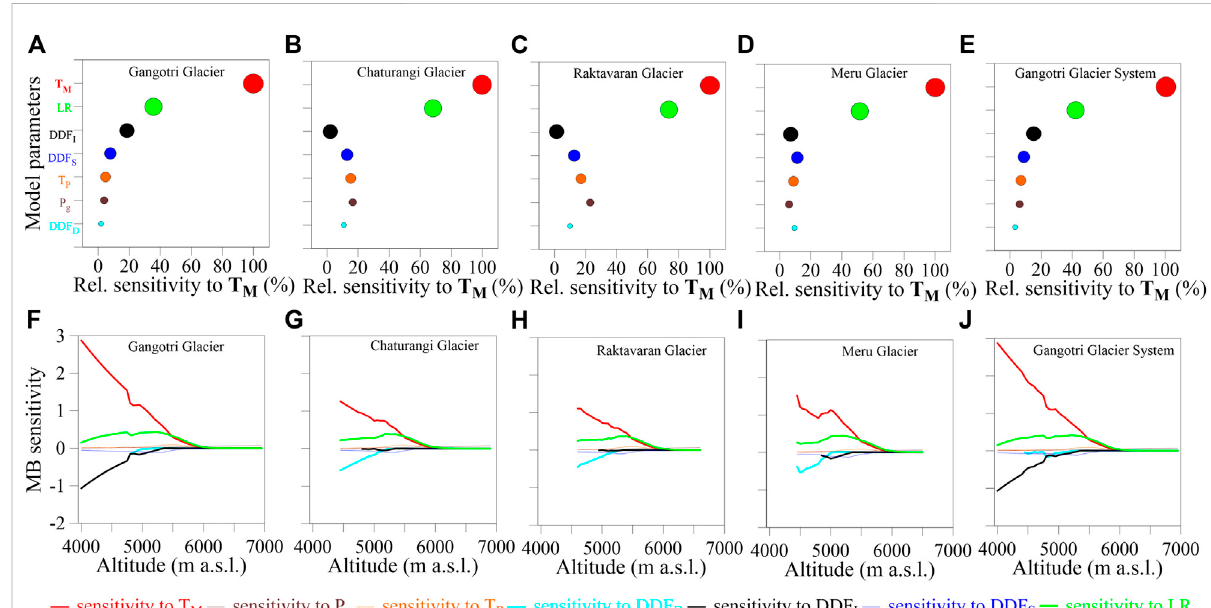
FIGURE 10 Panels (A – E) :BubbleplotsofrelativeMBsensitivitiesforallparameterscorrespondingto T M as100%forGangotri,Chaturangi,Raktavaran,Meru and Gangotri Glacier System, respectively. Panels (F – J) : Altitudinal MB sensitivities for all the parameters for Gangotri, Chaturangi, Raktavaran, Meru and Gangotri Glacier System,